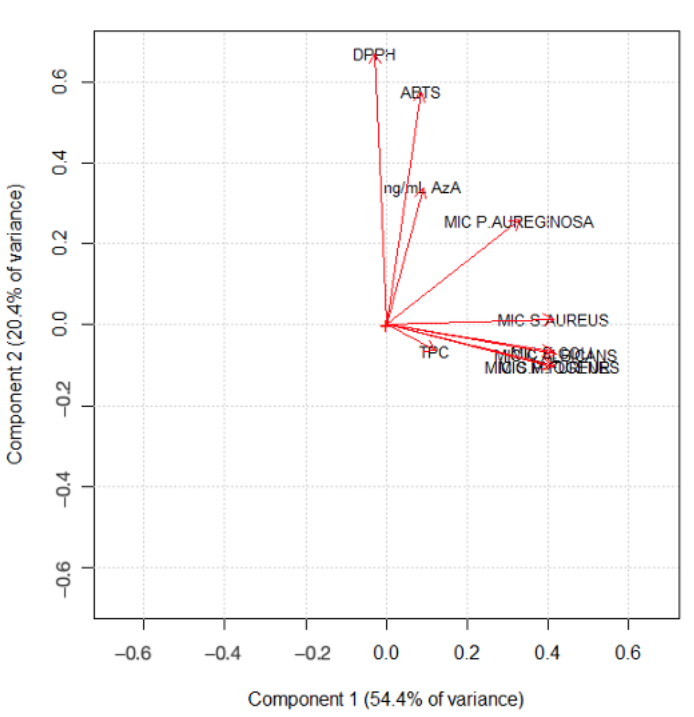
Figure 5. PCA loading plot of the first two principal components of the dataset.